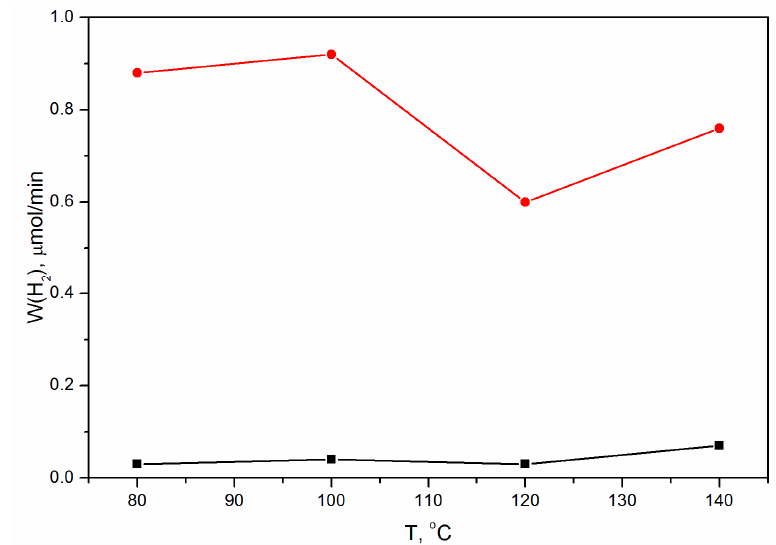
Figure 9. Dependence of the hydrogen evolution rate for CdS (black squares) and Cd 0.7 Mn 0.3 S-based catalysts (red circles) on the synthesis temperature T.